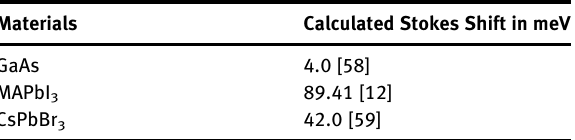
Table  : Reported values of Stokes shift.